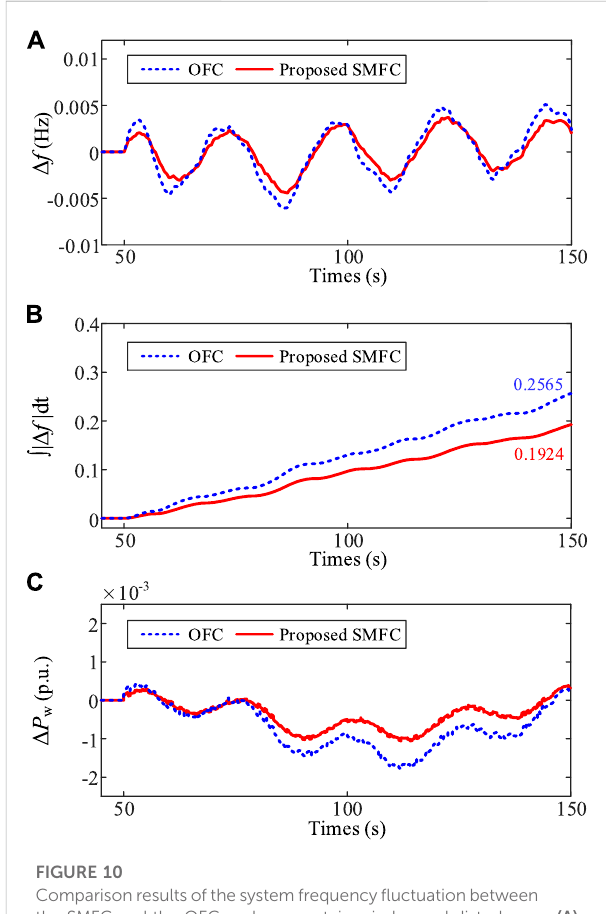
FIGURE 9 Comparison results of the disturbance observation between the STSMDO and the GESO under uncertain wind speed disturbance. (A) Lumped disturbance estimated result. (B) Estimation error. (C) Total estimation error , | Δ P d,estimated |dt.